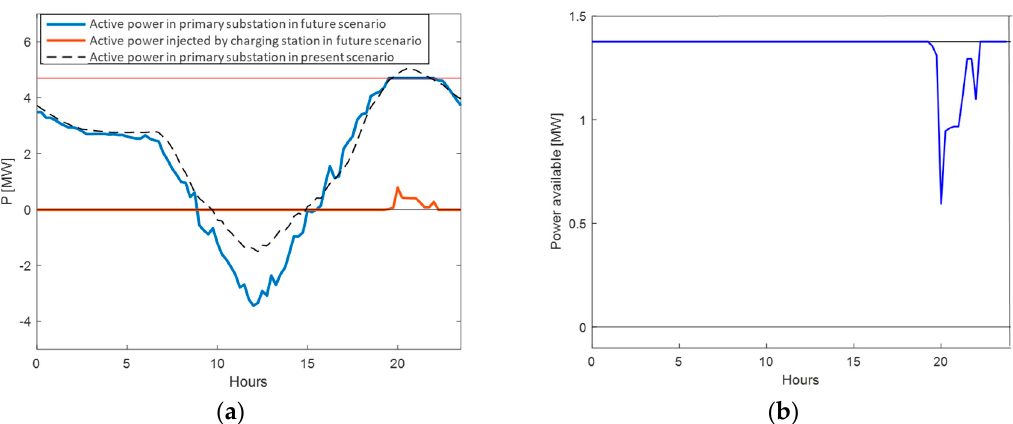
Figure 5. Active power at the MV side of the primary ESS and power injected by the EV home stations for the evening peak shaving ( a ); power available by the home stations ( b ).